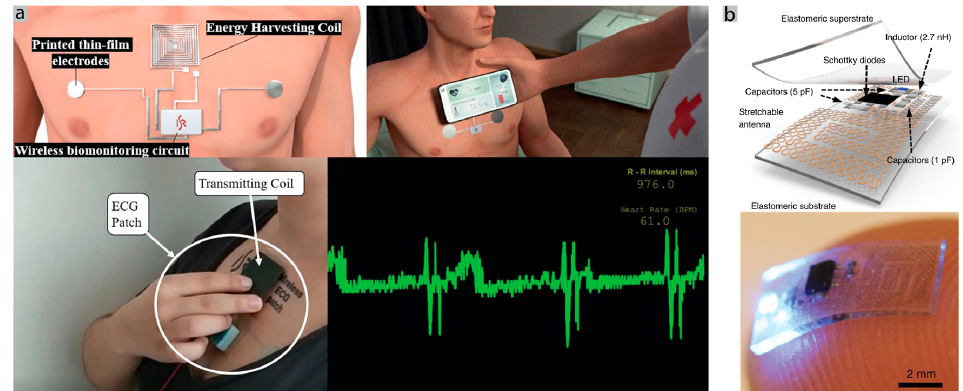
Figure 7. Energy harvesting devices. ( a ) Fully wireless and battery-less ECG patch, powered by near field radio frequency energy harvesting. Adapted with permission from [87]. ( b ) Miniaturized implantable optogenetics system, of rigid, interconnects Ti/Au in a serpentine shape. It has a stretchable antenna being capable of energy harvesting by radio waves. Adapted with permission from [121].